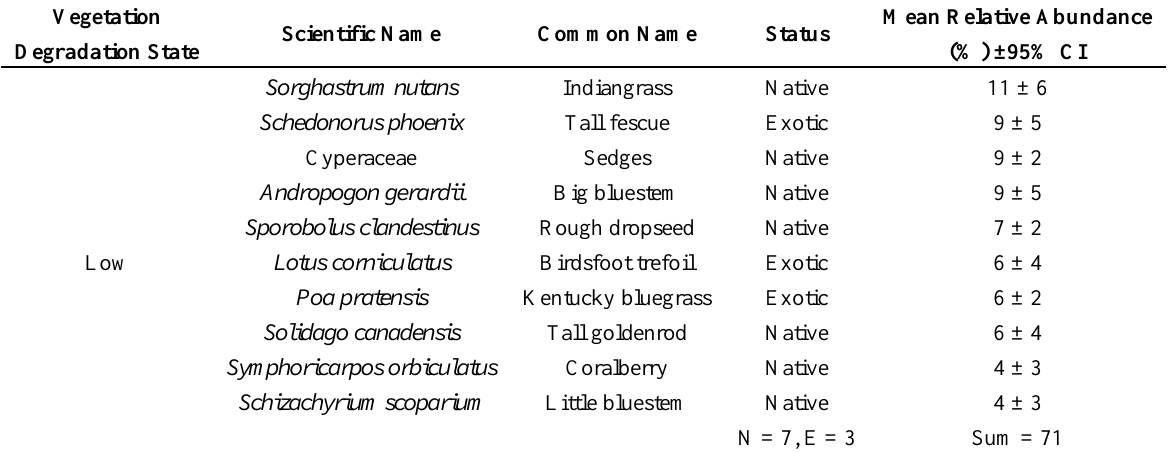
Figure 1. Ordination of plant species composition from 54 modified Whittaker plots (plots) by Nonmetric Multi-Dimensional Scaling (NMDS) of Canberra distances (k = 4, stress ≈ 12%). The ordination is based on 196 plant species abundance sampled from nine tracts in the Grand River Grasslands of south-central Iowa and north-central Missouri, USA. Plant communities are plotted by tract and grazing history. The six Whittaker plots of each tract are connected by minimum convex hulls in which unbroken lines denote tracts with a recent history of severe grazing, and broken lines denote tracts with no recent history of grazing. Arrows indicate vectors of increase along a gradient of variation within ordination space for each factor. Arrow length is proportional to the correlation between a variable and the NMDS axis closest to parallel with the vector. Vector